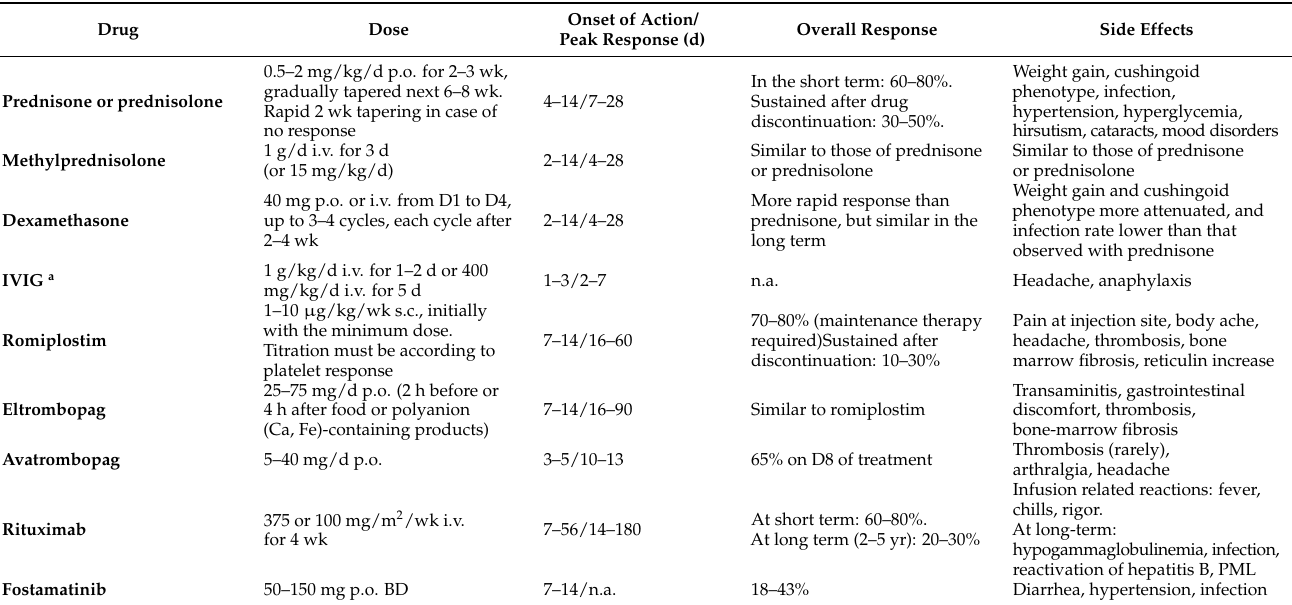
Table 3. Dosage, response rate, and side effects of the current first- and second-line drugs indicated to treat ITP patients